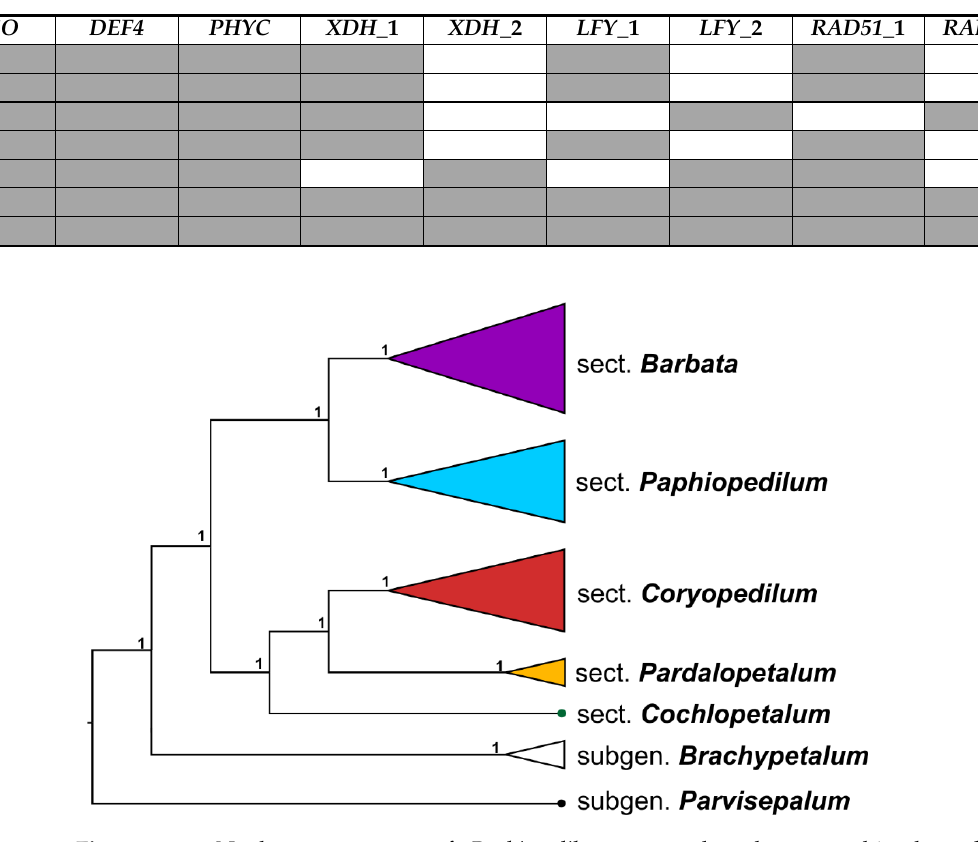
Figure 1. Time-calibrated gene trees of Paphiopedilum genus (maximum clade credibility trees) resulting from BEAST analysis of the nuclear data: a — XDH ; b — LFY ; c — RAD51 ; d — PHYC ; e —combined XDH / LFY / RAD51 / PHYC ; f —combined XDH / LFY / PHYC ; g — ACO ; h — DEF4 ; j — ACO / DEF4 ; and i —plastid combined data. Posterior Probability (PP) values >